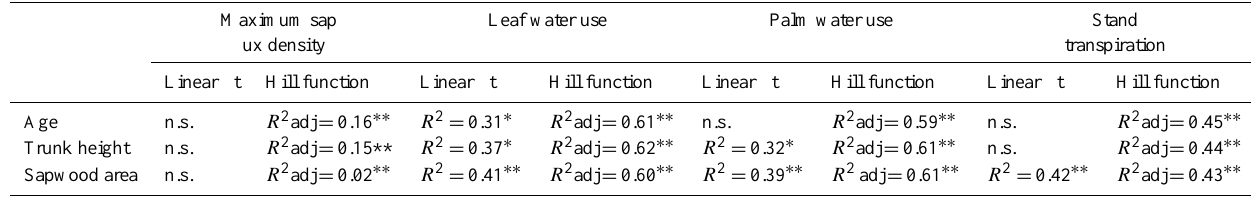
Table 2. Summary table of results for all 15 oil palm stands. R 2 and P values for linear regression and fitting a Hill function, respectively, are presented to explain variability in water use characteristics (i.e., maximum sap flux density, leaf water use, palm water use and stand transpiration) by the stand variables age, trunk height and sapwood area.